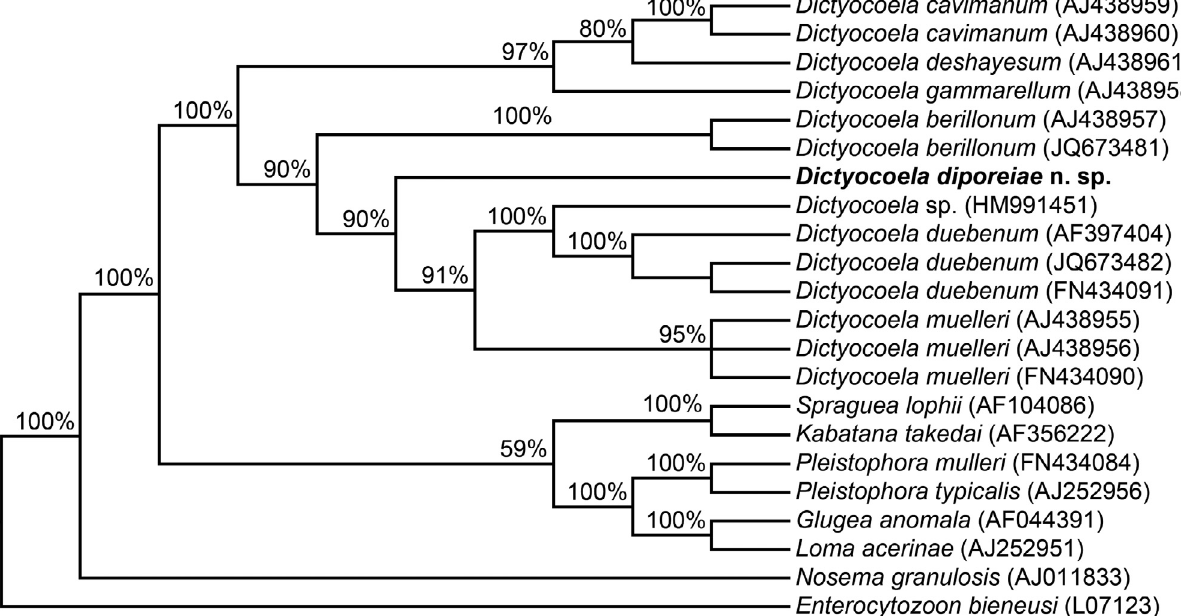
Figure 6. Phylogenetic tree (50% majority-rule consensus) based on Bayesian Inference (MrBayes 3.1.2) of Dictyocoela spp. based on the small subunit ribosomal gene. Numbers at the nodes are Bayesian posterior probabilities. Spaguea lopii , Kabatana takedai , Nosema granulosis , Thelohania parastaci , Pleistophra mulleri , P. typicalius , Glugea anomala , and Loma acerinae were used as an outgroup for Dictyocoela spp. based on the results of Krebes et al.